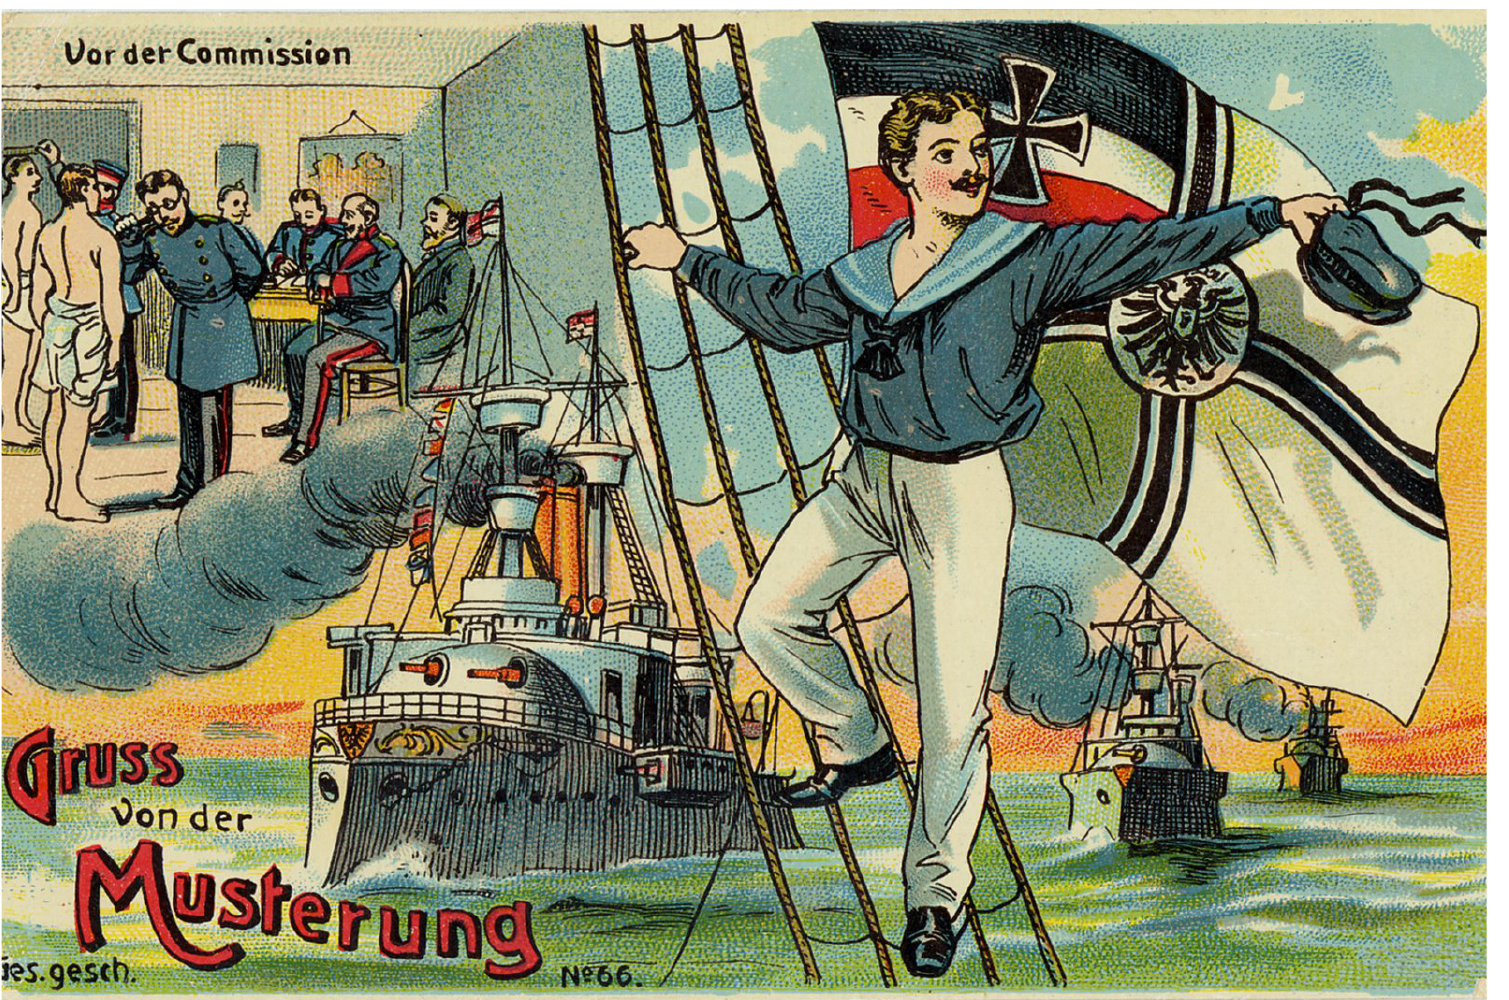
Artist unknown, Gruss von der Musterung (Greetings from the Muster). c. 1913. Postcard. Stiftung Historische Museen Hamburg-Altonaer Museum. 13.8 x 9